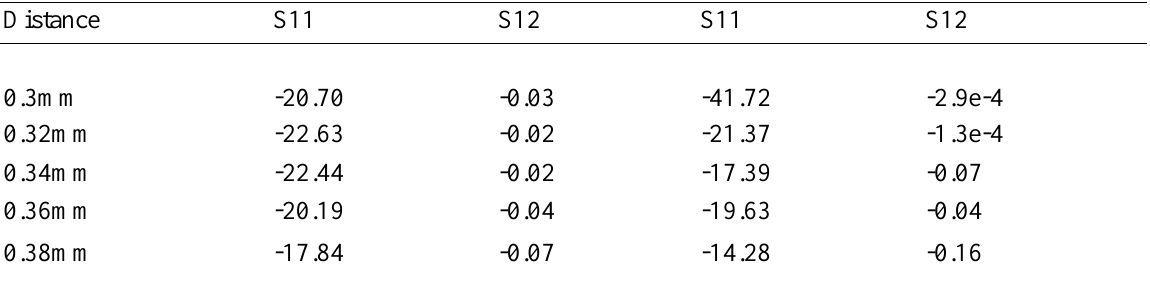
Table 1. Changing distance of the